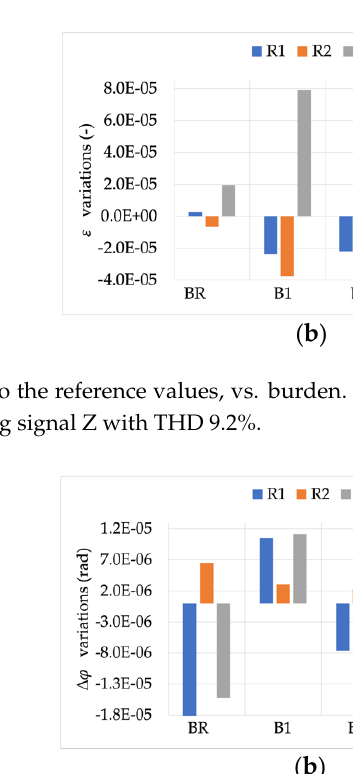
Figure 7. ∆𝜑 variations, compared to the reference values, vs. burden. ( a ) RCs ’ measuring signal Y with THD 4.8%; ( b ) RCs ’ measuring signal Z with THD 9.2%.